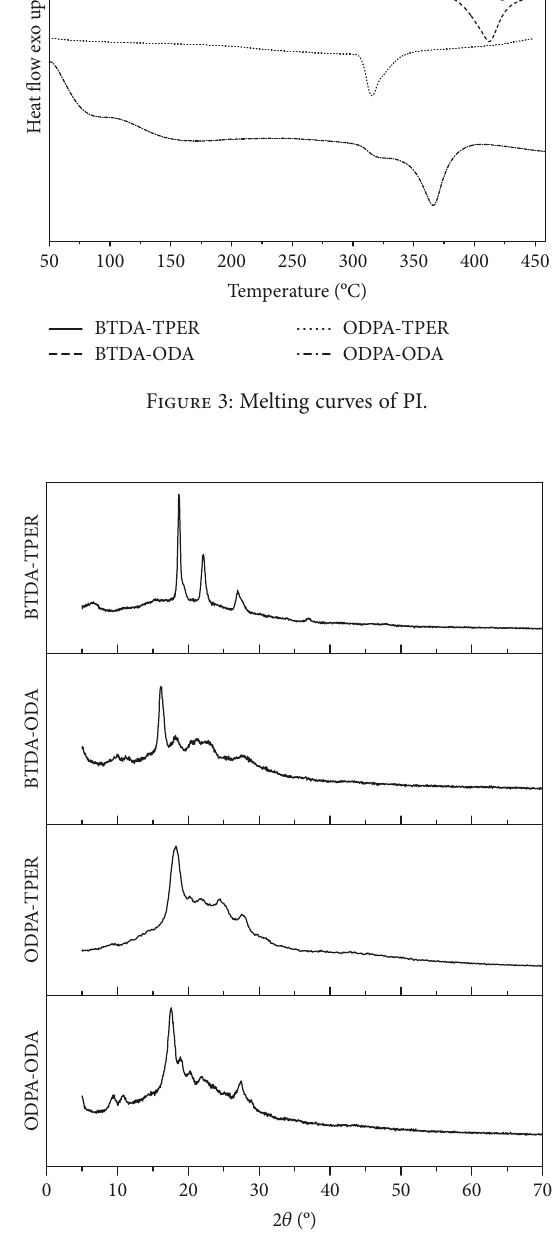
Figure 4: XRD patterns of